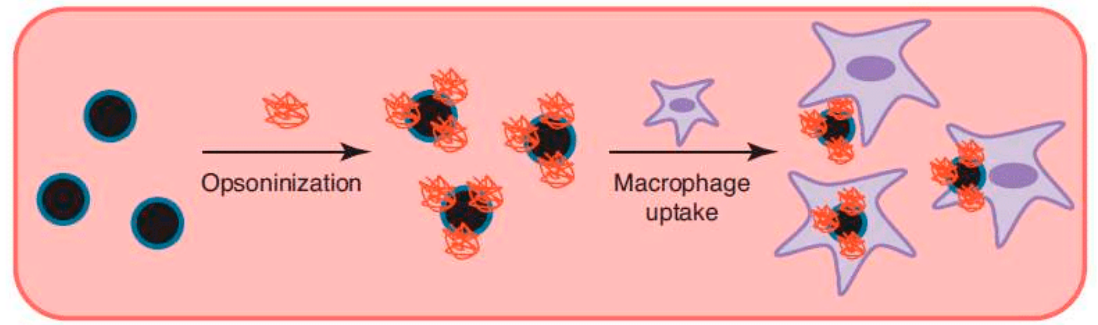
Figure 4. Opsonization of nanoparticles in the bloodstream will lead to rapid clearing by the reticuloendothelial system via phagocytic uptake of the particles by macrophages (reproduced from Reference [39] with permission from Elsevier).